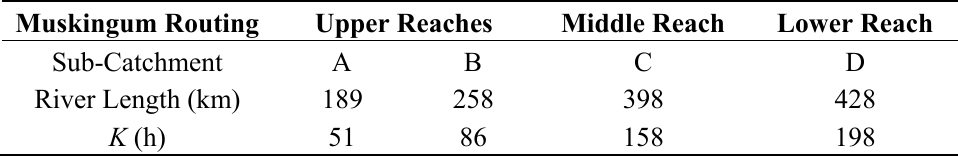
Table 1. Muskingum routing parameter K for